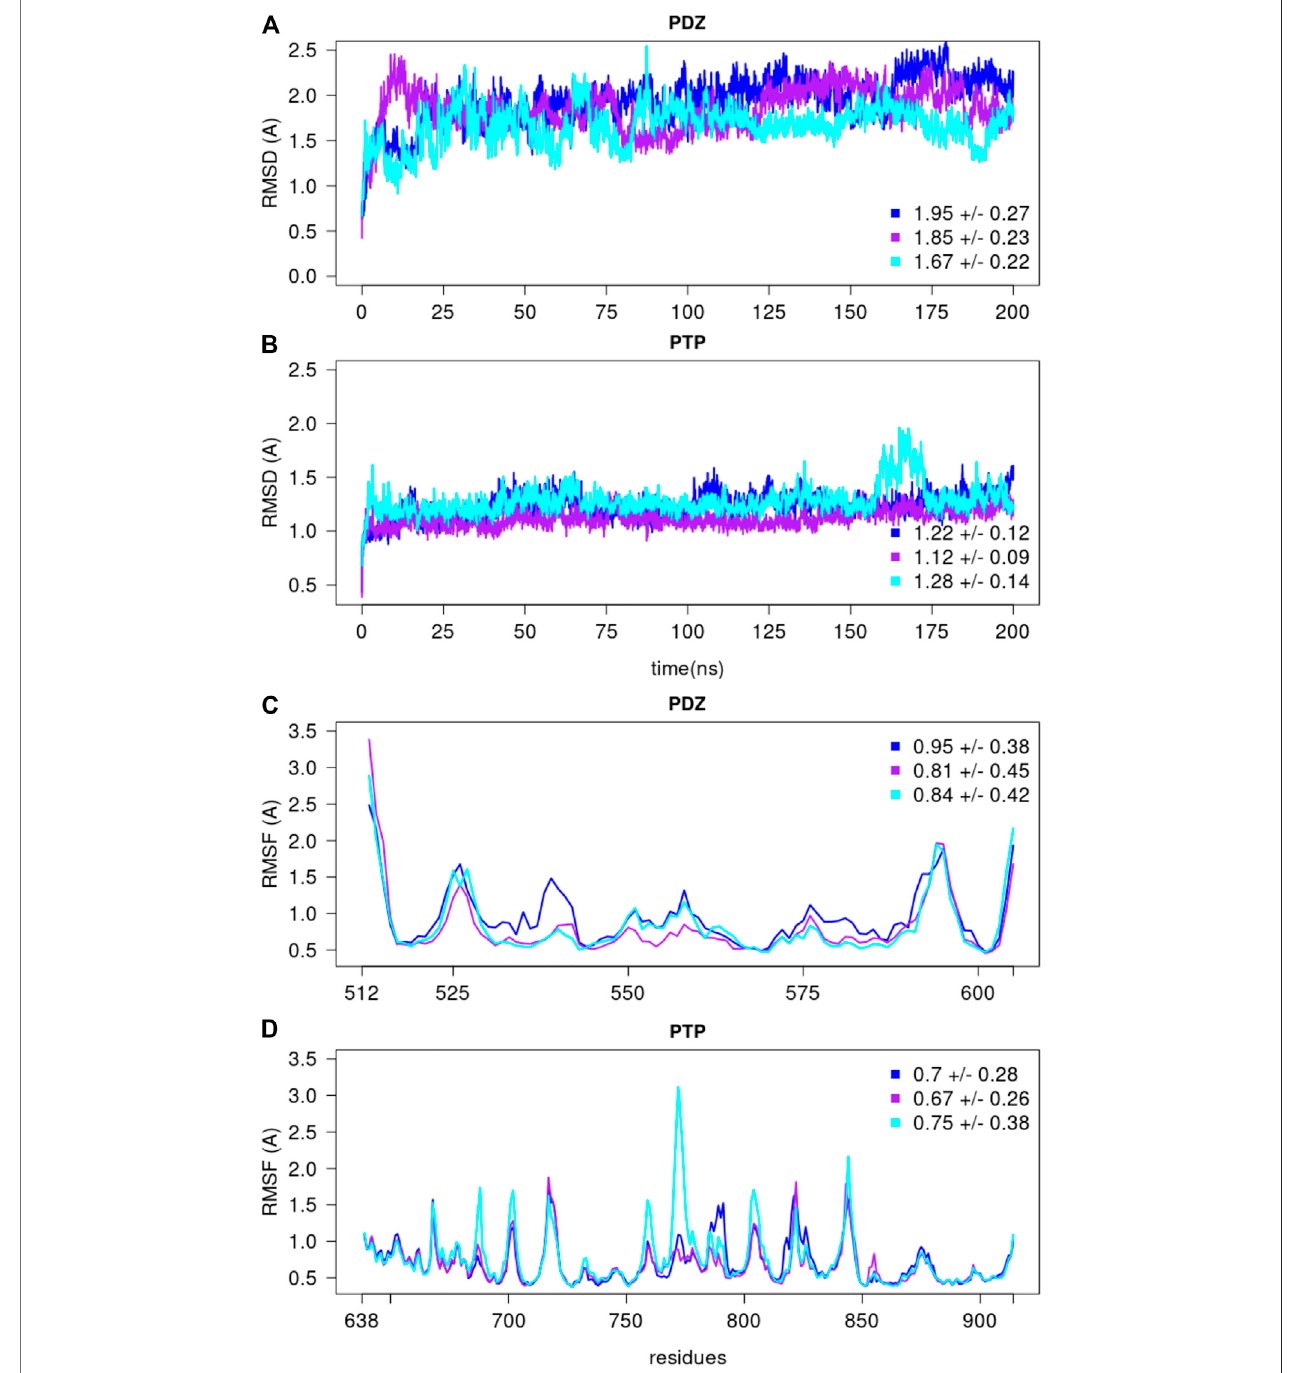
FIGURE 11 | The root mean square deviations and fl uctuations of each MD simulation. The RMSD over backbone atoms (C α , C, N, O) measured from the initial structureareshownforthe (A) PDZand (B) PTPdomains.TheresidueRMSFoverbackboneatoms(C α ,C,N,O)measuredwithrespecttotheaverageconformationare depicted for the (C) PDZ and (D) PTP domains, over the last 150 ns of each replicate. The average and standard deviation values are reported for every replicate.